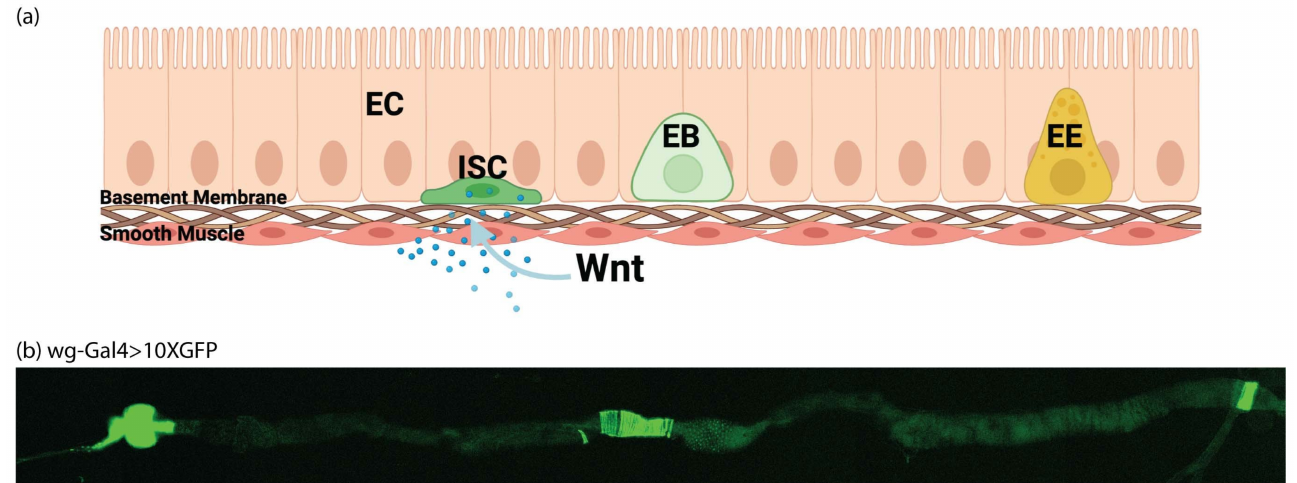
Figure 2. Wnt expression in the Drosophila gut. ( a ) Model of the Drosophila gut comprising enterocytes (ECs), enteroendocrine (EEs), enteroblasts (EBs) and intestinal stem cells (ISCs). ISCs rest on the external surface of the gut epithelium away from the gut lumen and divide symmetrically to make more ISCs or asymmetrically to form EBs. ( b ) Representative midgut section of a wg-Gal4 > 10 × GFP fly. Each of the six clusters was enriched for distinct pathways and processes (Figure 5d,e, Supplemental Tables S2 and S3). Cluster I (N = 440) contained genes that were